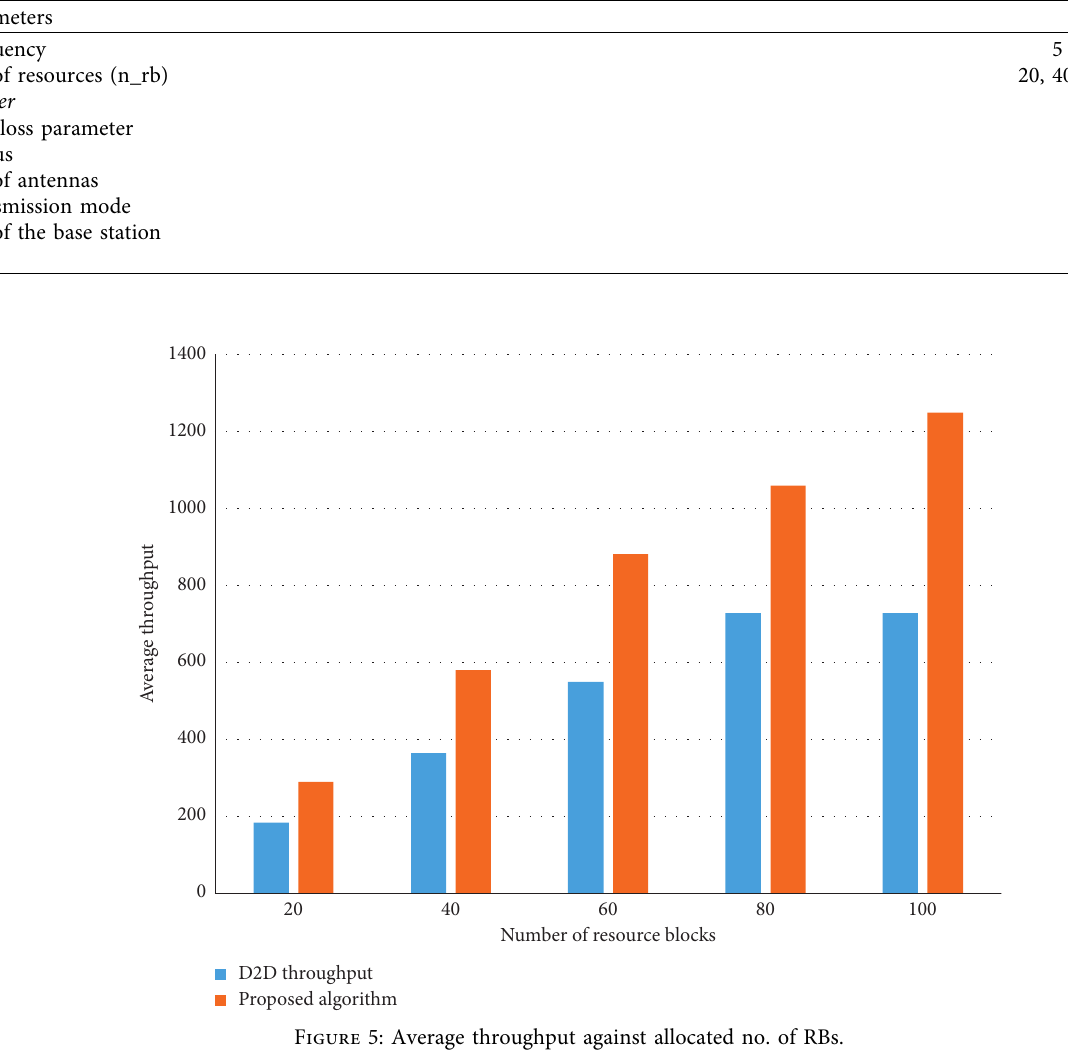
Table 2: Parameters set to calculate